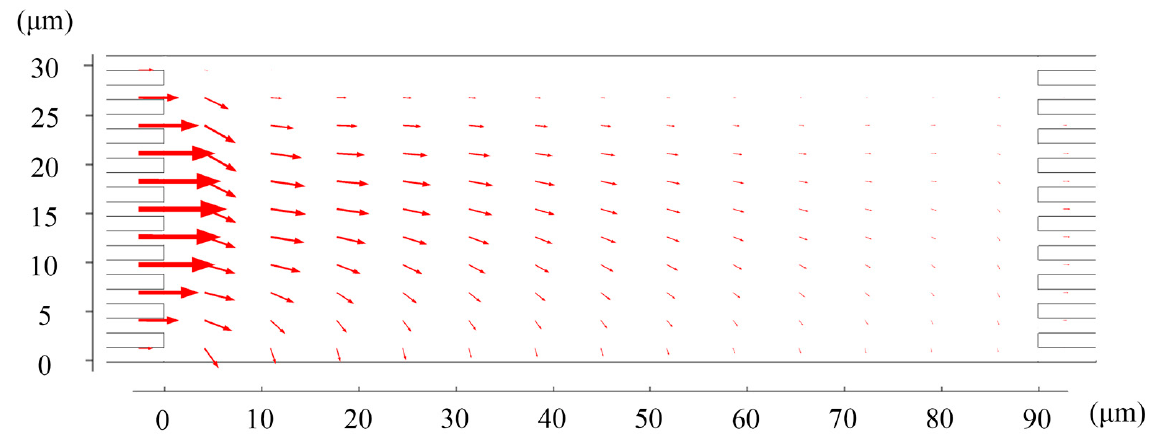
Figure 4. The flux distribution of Mg 2+ . Values of other parameters are: V = 30V T , u out = 1 mm/s, u 1 = 0.63 mm/s, and u 2 = 1 mm/s.